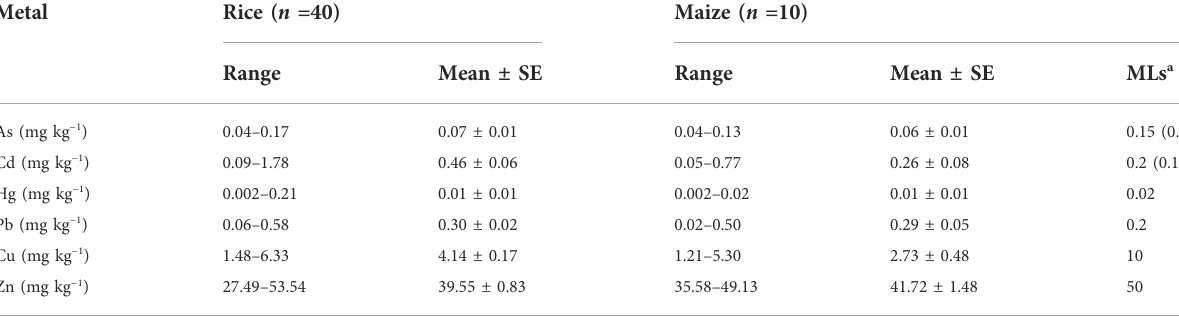
TABLE 2 Metals concentrations (on dry weight basis) in the edible parts of food crops collected from the study